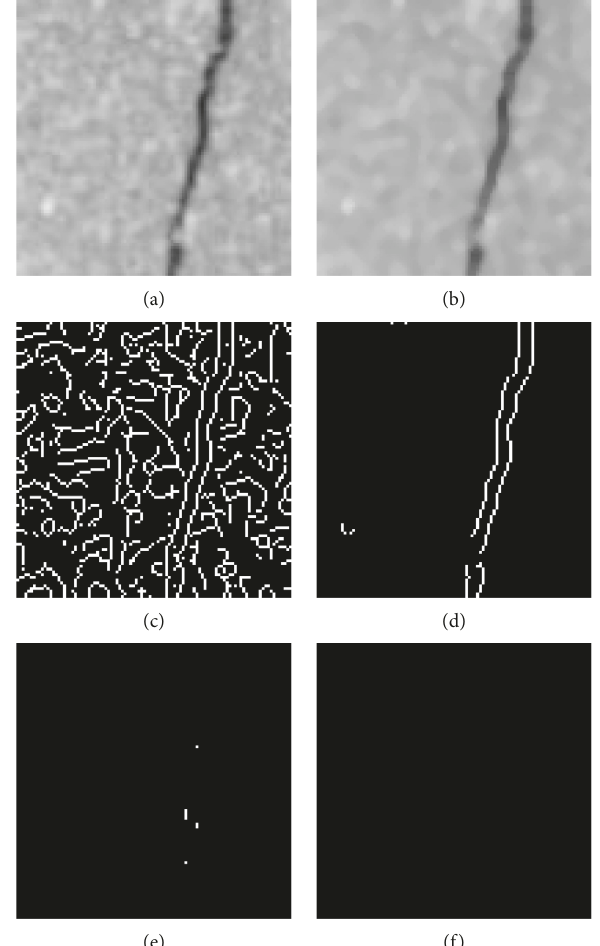
Figure 3: Examples of image enhancement with SBF. (a) Original image. (b) Median filter enhancement. (c) SBF: T T S � 0.05. (e) SBF: T S � 0.10. (f) SBF: T S �